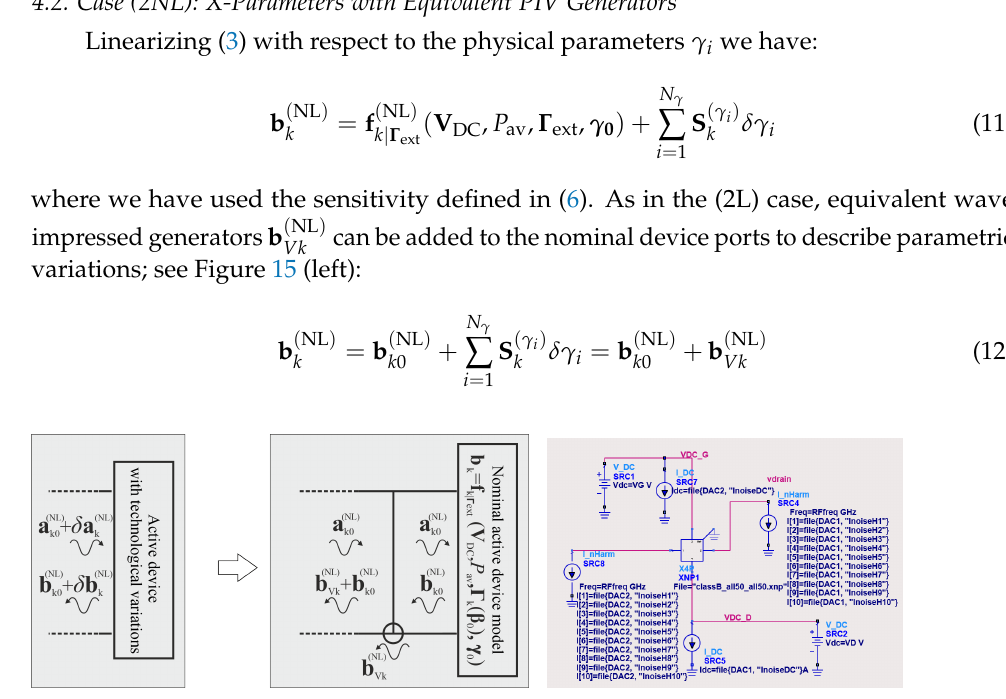
Figure 15. ( Left ): Representation of the technological variability with impressed PIV generators ( NL ) b at the nonlinear block ports. ( Right ): ADS schematic implementation: short-circuit current Vk generators in parallel to the device ports (DC and RF) are exploited akin to wave